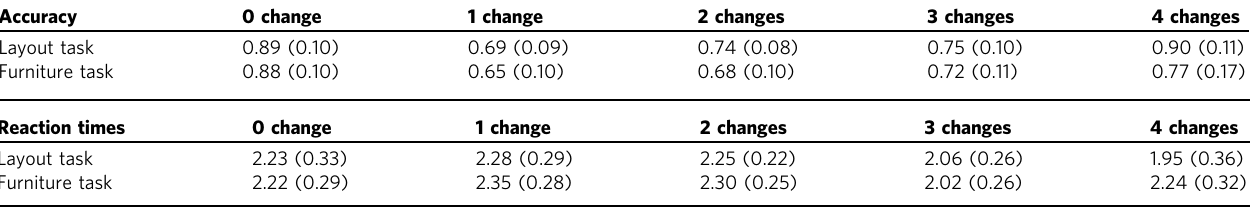
Table 1 Accuracy rates and reaction times (for accurate responses) in the Layout and Furniture tasks. Accuracy 0 change 1 change 2 changes 3 changes 4 changes Layout task